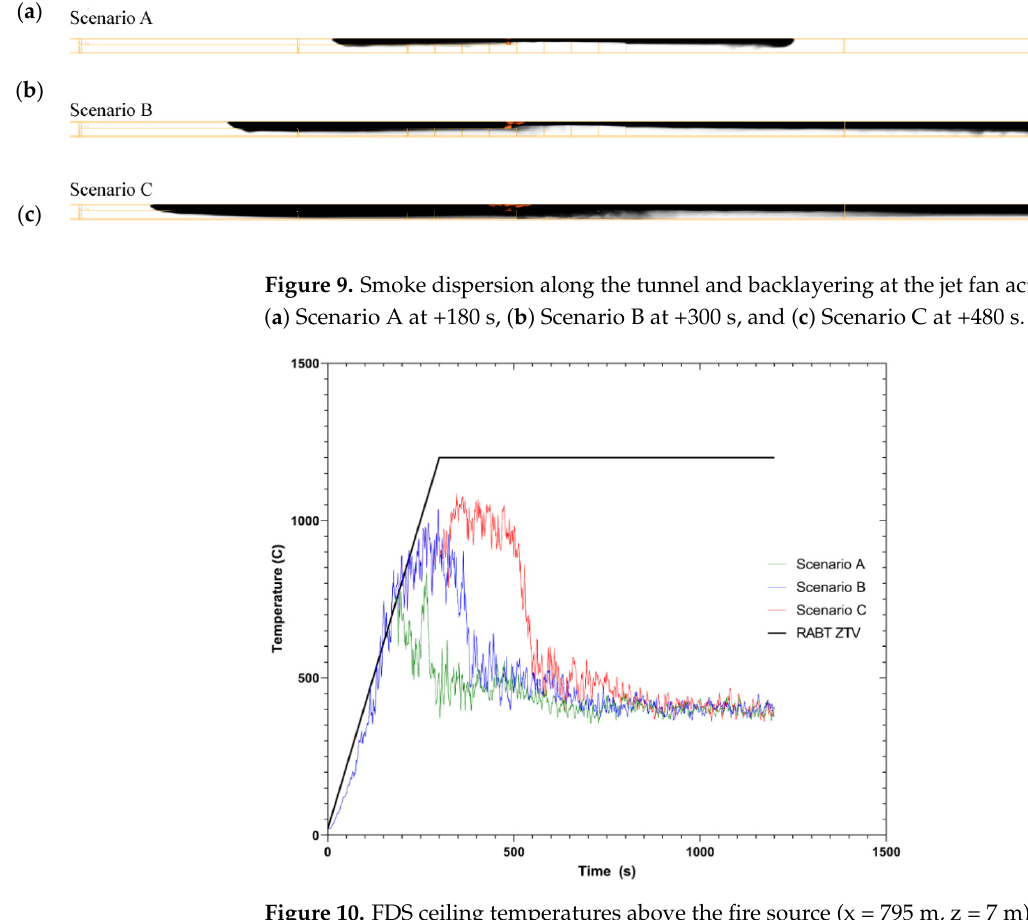
Figure 10. FDS ceiling temperatures above the fire source (x = 795 m, z = 7 m) for all three scenarios in comparison with the RABT ZTV fire curve.